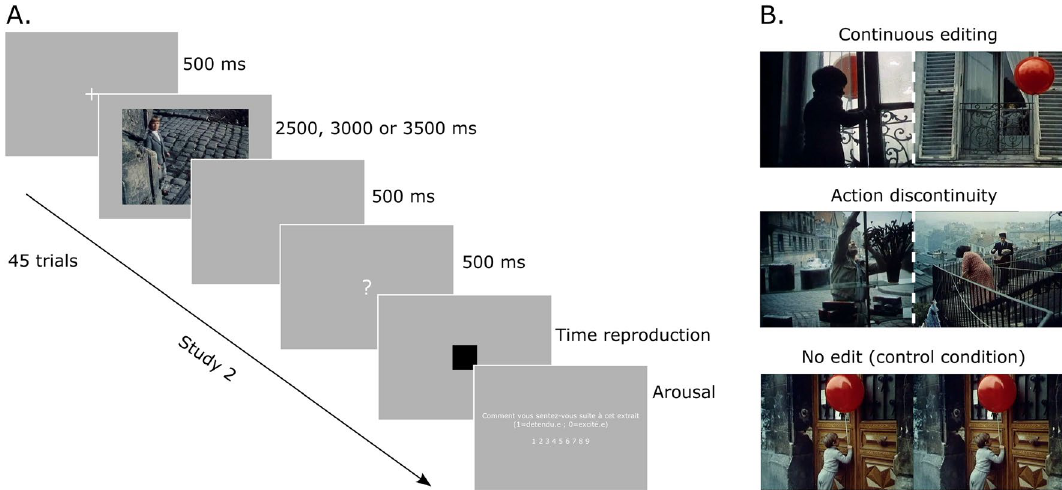
Figure 2. ( A ) Example of time course for Study 2. Stimuli were presented after a fixation cross (500 ms) for one of the three durations (2500, 3000 or 3500 ms). Then, an empty screen (500 ms) followed by a question mark (500 ms) were shown before the appearance of a black square at the center of the screen. Participants had to press the spacebar when they estimated that the duration of presentation of the square was equivalent to the duration of the preceding video clip. After the time reproduction, an arousal scale was presented. ( B ) Examples of edits for each condition. In the continuous condition, two edited sequences show the same action although a change of perspective (a child looking out of the window), while in the action discontinuity condition the edited sequences present two separate actions. In the control condition the were no